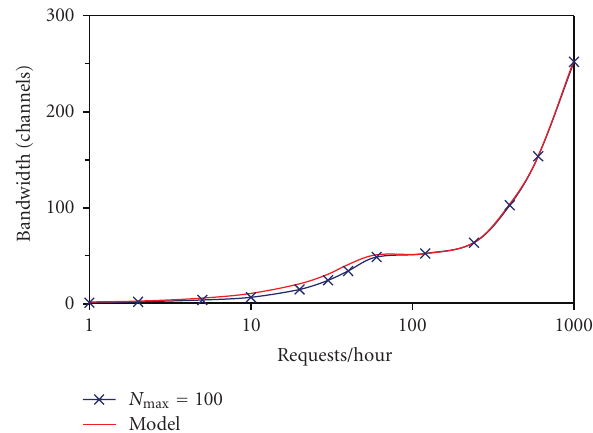
Figure 11: Network bandwidth requirements of the protocol for α = 0.25, β = 0.25, and N = max max